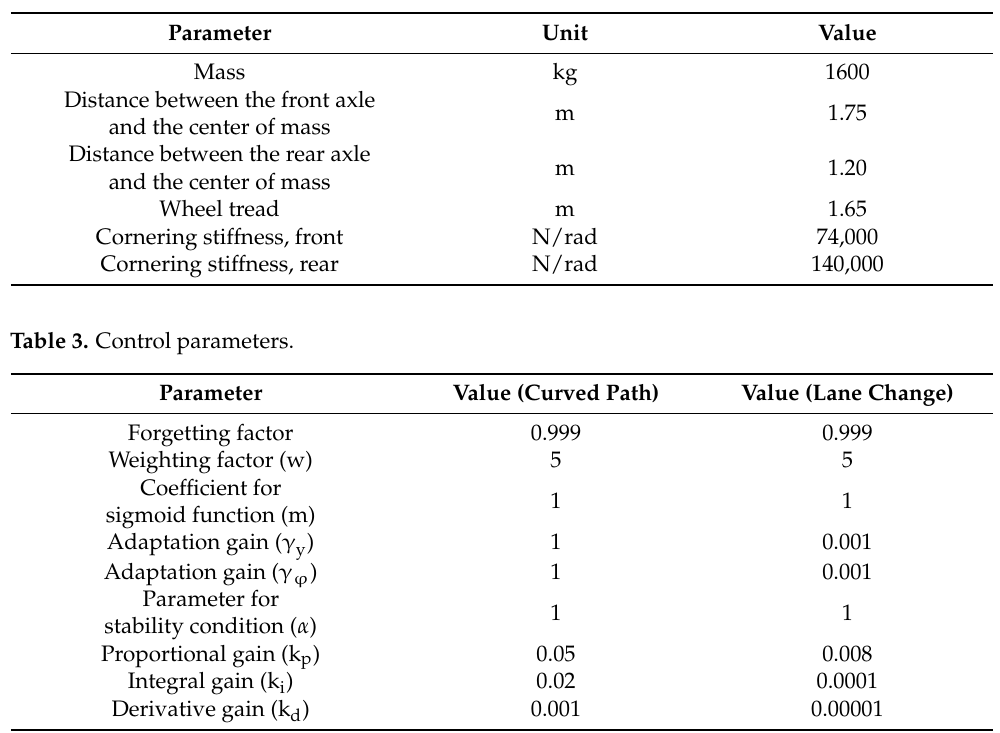
Figure 6. Results: estimated coefficients in the case of AFC for the curved path tracking.